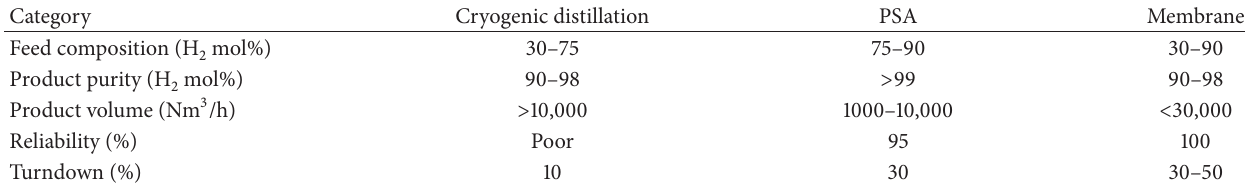
Table 6: Comparison between current technologies for hydrogen recovery [105].